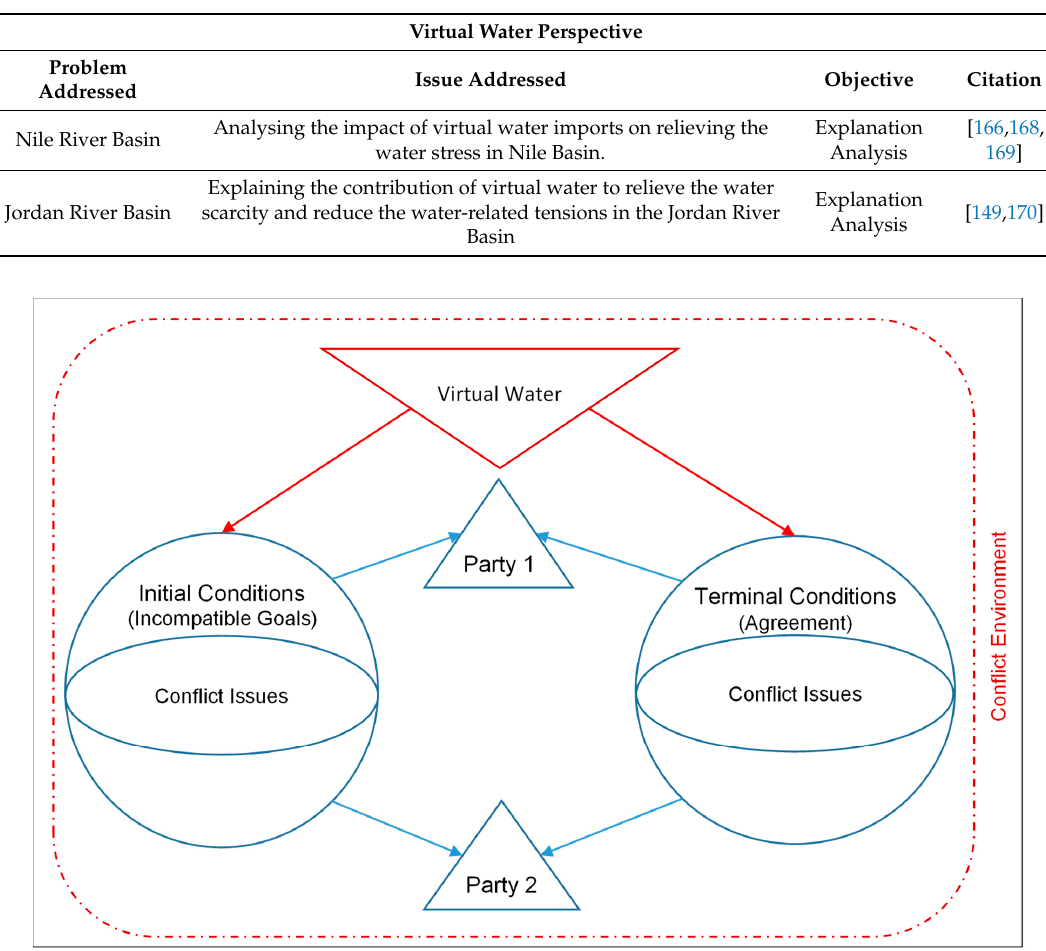
Figure 9. Structure of Virtual Water Mechanism. Table 8. Virtual Water Mechanism—Theory and Implementation.